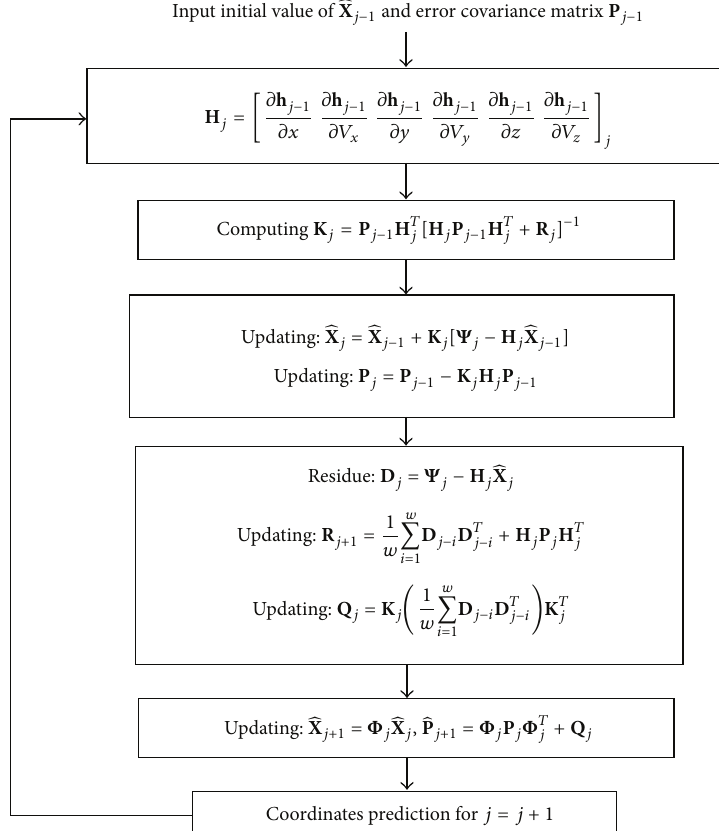
Figure 6: The flow chart of AEKF